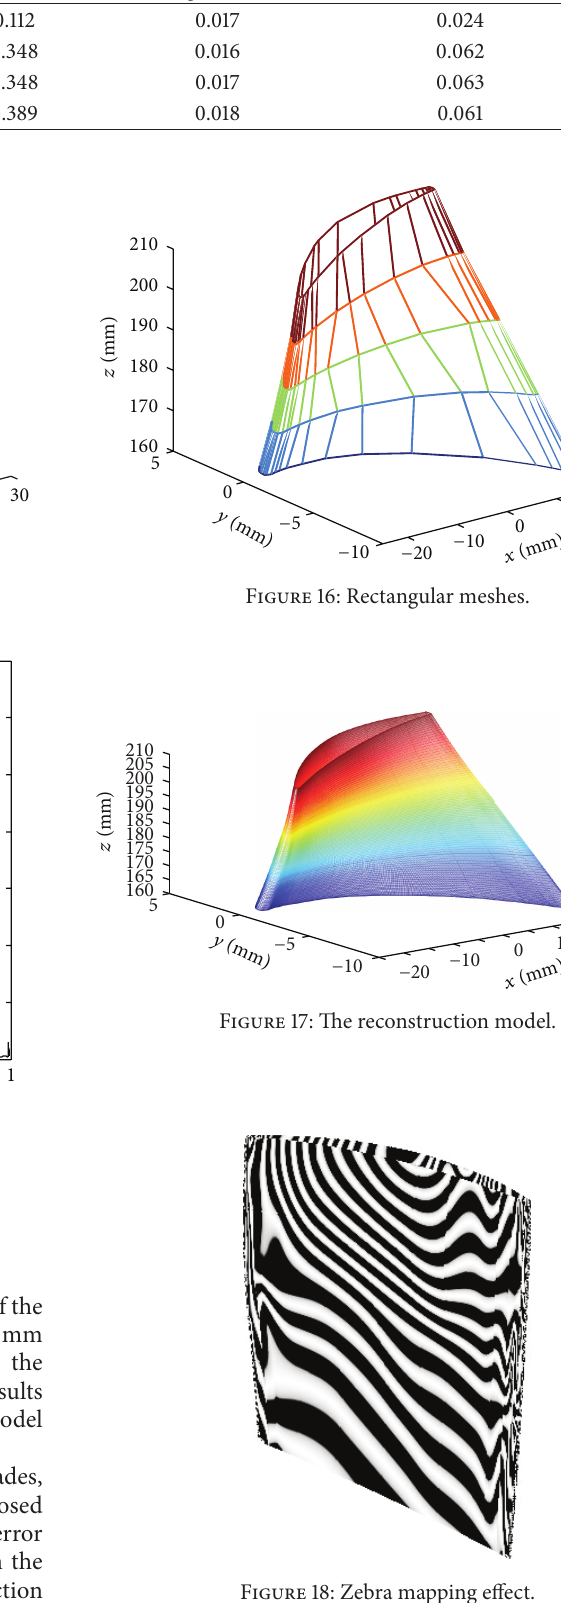
Figure 18: Zebra mapping